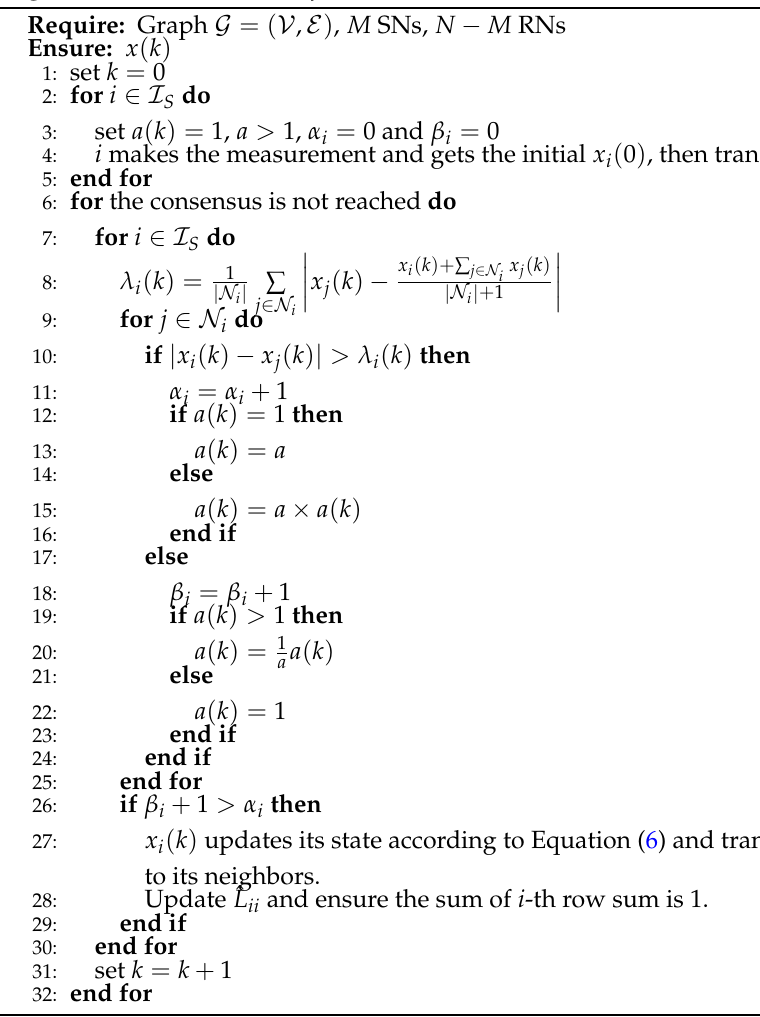
Algorithm 1: Parameter Adjusted-Based Consensus Scheme